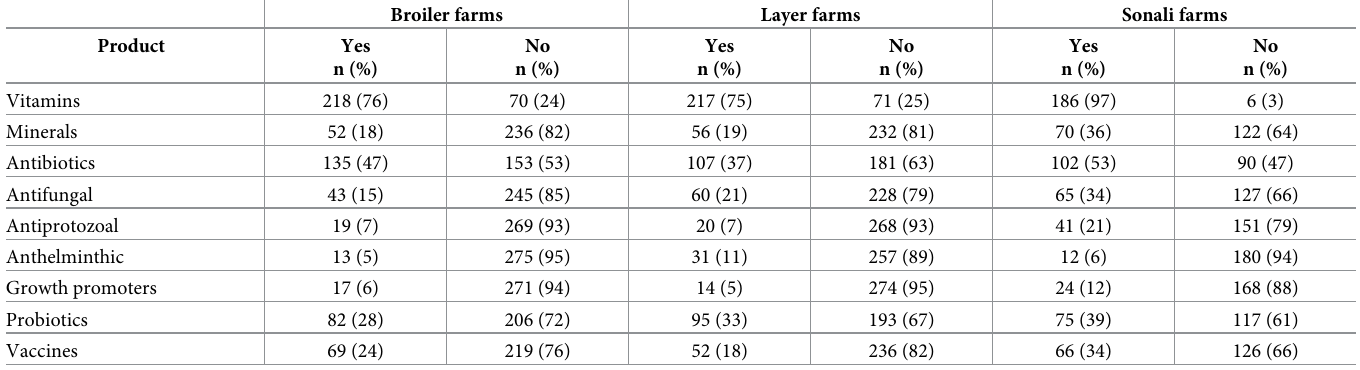
Table 4. Drugs, vaccines and associated products used within the 72 hours preceding visits to selected broiler (N = 288), layer (N = 288) and Sonali (N = 192) farms in Bangladesh during January-May 2021.